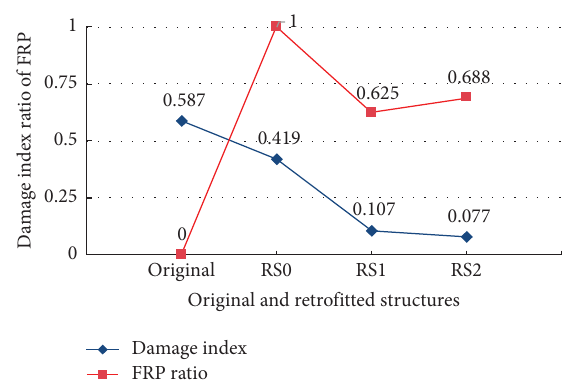
Figure 18: Variations of damage index and FRP ratio.